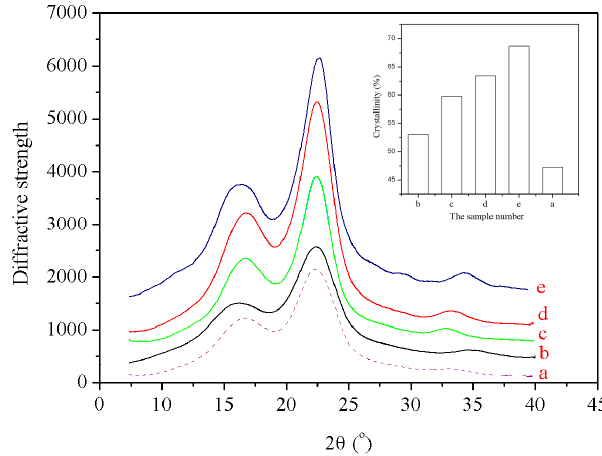
Figure 5. X-ray diffraction (XRD) patterns obtained for the untreated wood fibers and the wood fibers modified through a high temperature and pressurized steam treatment under different conditions: a untreated fibers; b T = 120 °C, p = 0.2 MPa, t = 5 min; c T = 160 °C, p = 0.6 MPa, t = 5 min; d T = 140 °C, p = 0.6 MPa, t = 15 min; and e T = 170 °C, p = 0.8 MPa, t = 5 min.